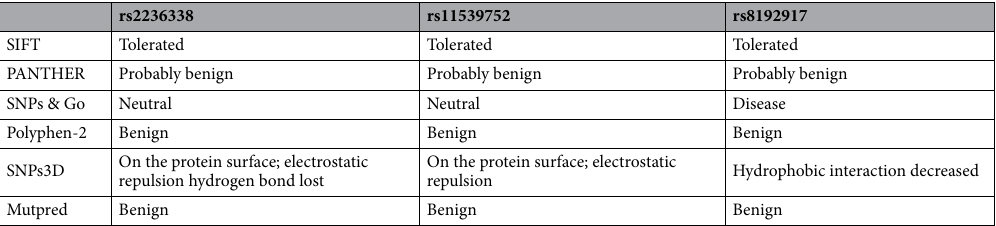
Table 4. In silico analysis according to non-synonymous